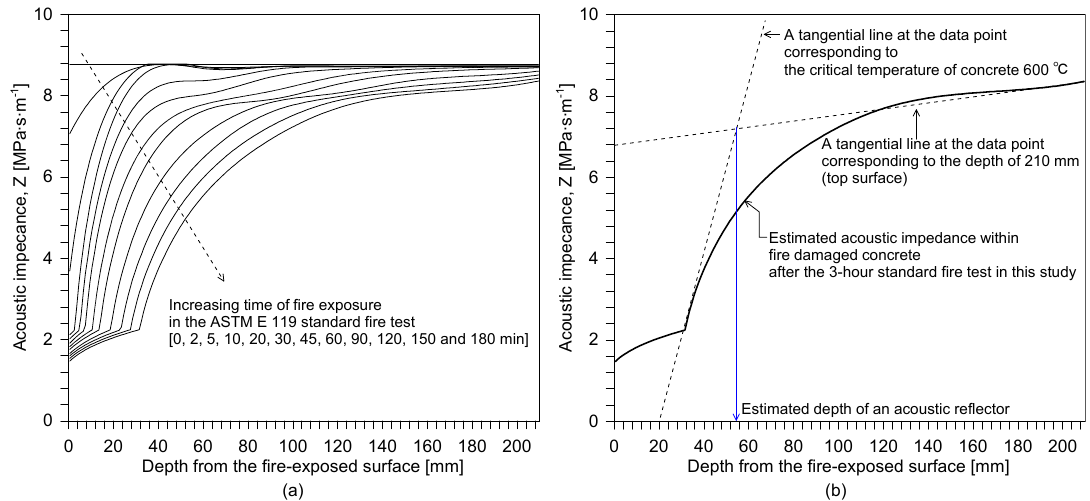
Figure 17. Acoustic impedance within fire-damaged concrete: ( a ) predicted acoustic impedance within fire-damaged concrete with increasing the time of fire exposure after the ASTM E 119 standard fire test, and ( b ) an example of determining the approximate depth of an acoustic reflector in fire-damaged concrete.